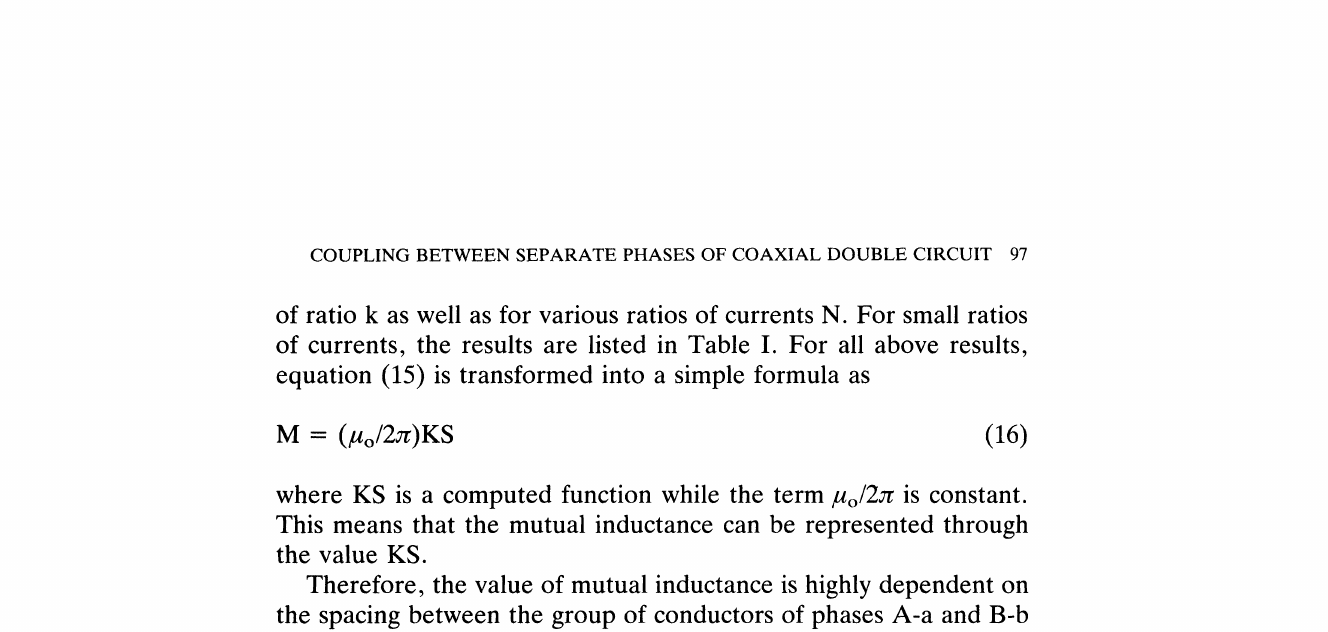
The computed values of the function KS at small ratios of currents (zero phase shift) N